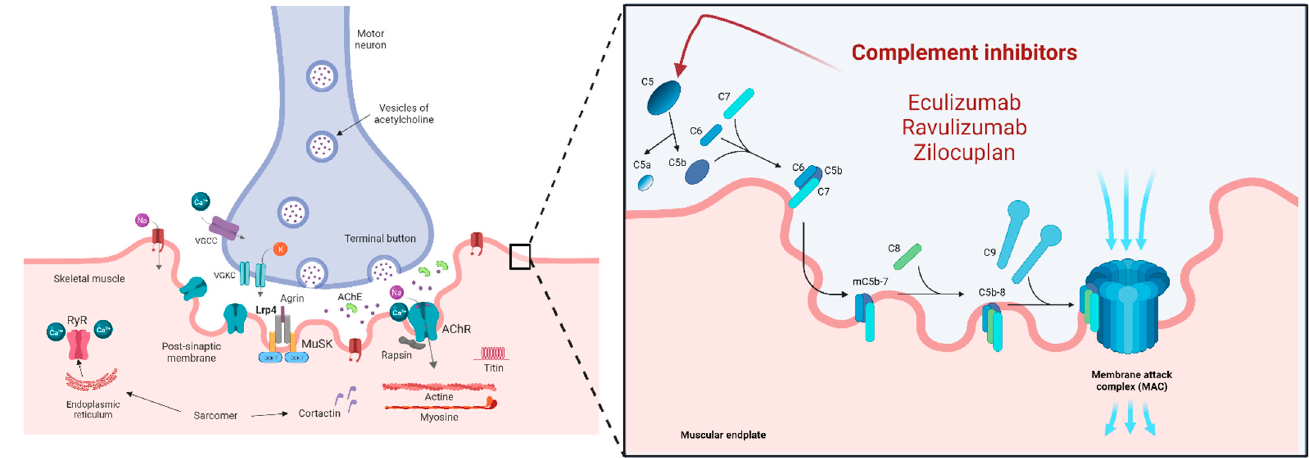
Figure 2. Complement inhibitors and their mechanisms of action are represented in this figure. At the muscular endplate, the complement system activates the membrane attack complex (MAC) as its last step, contributing to the destruction of the architecture of the muscular surface in MG. Eculizumab, Ravulizumab and Zilocuplan inhibit the complement system by blocking C5 action.